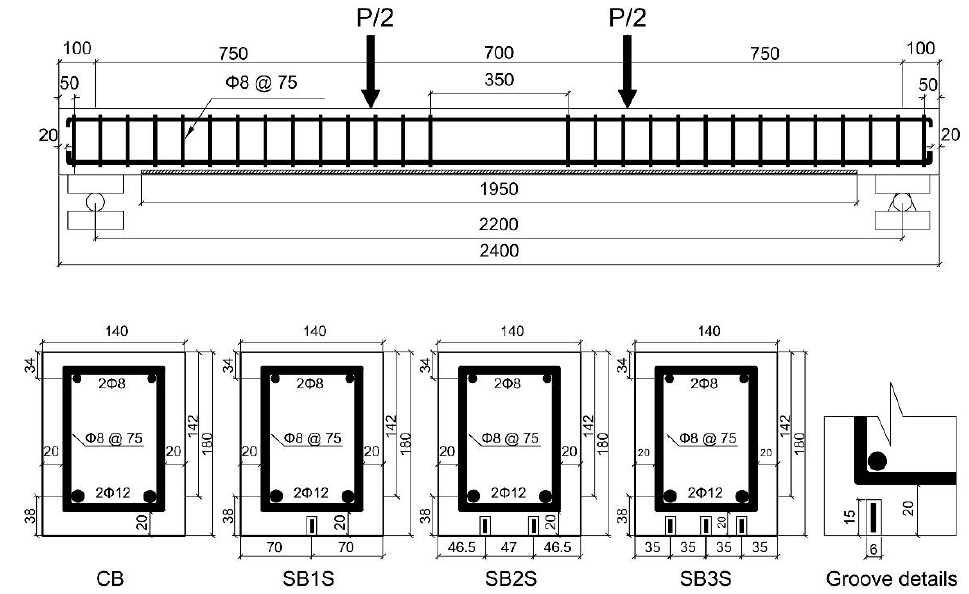
Figure 1. Beam details (dimensions in mm).